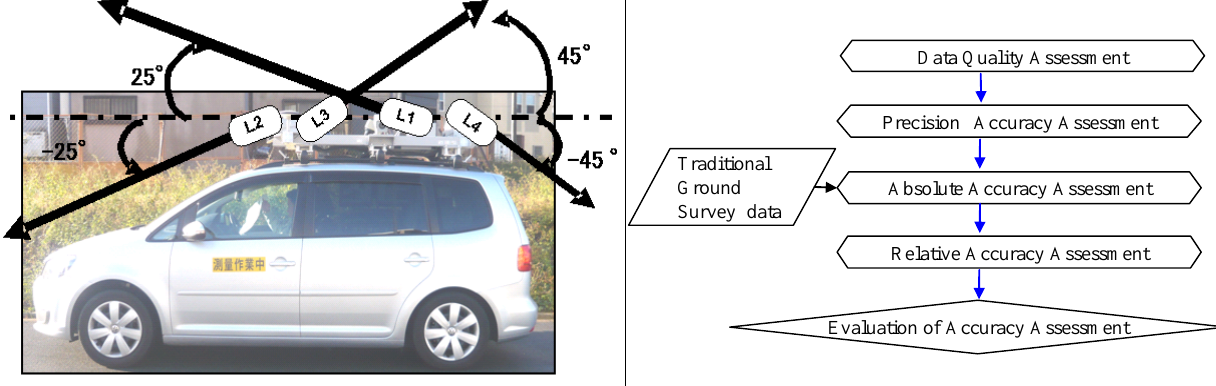
Figure 2. Four laser scanners’ irradiation direction Figure 3. Accuracy Assessment